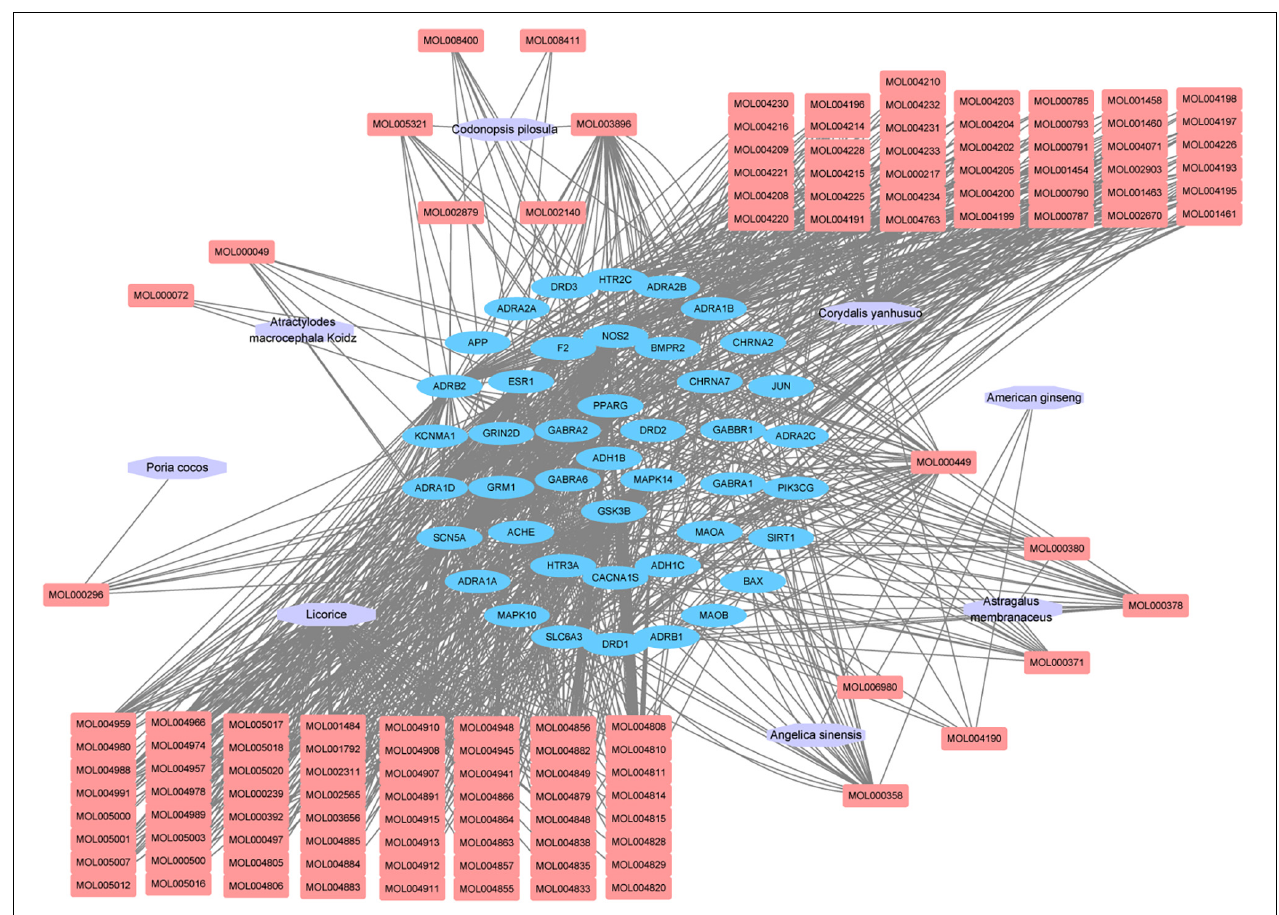
FIGURE 2 | “Herb-compound-target” network of candidate Chinese herbal medicine (CCHM) in the treatment of methamphetamine (METH) addiction. The purple polygons represented different herbs. The pink squares represented active compounds of herbs, and the blue circle represented potential protein targets. The edges represent the interactions between